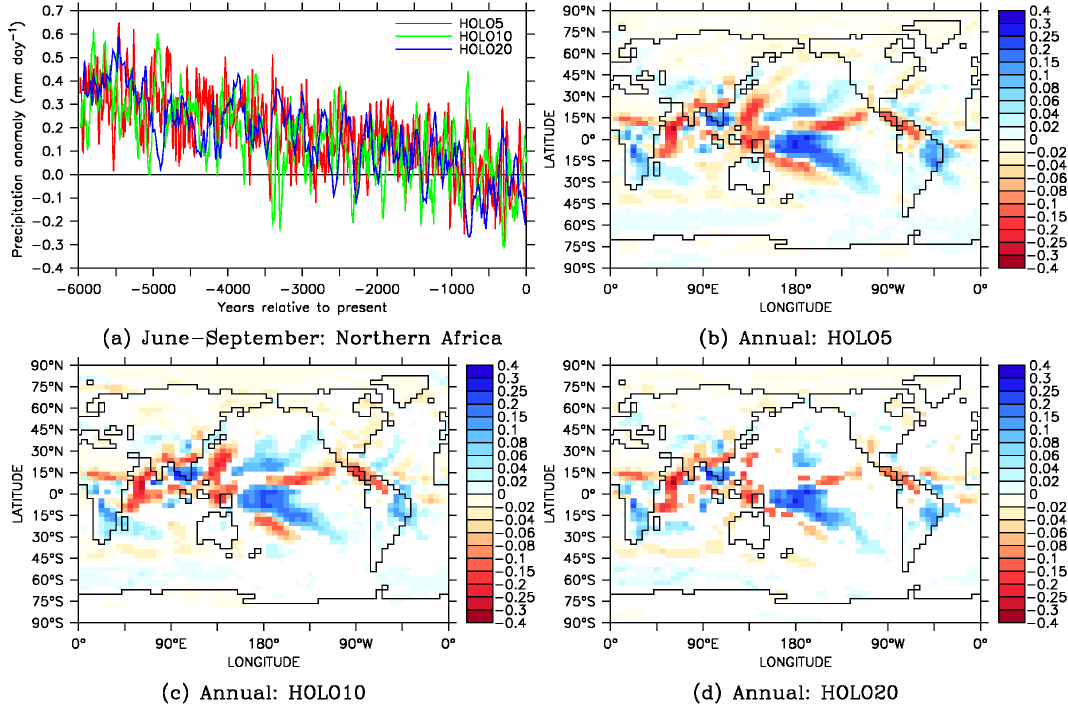
Fig. 10. The evolution of precipitation during the late Holocene: (a) June–September precipitation over Northern Africa (20 ◦ W–30 ◦ E, 10– 25 ◦ N), expressed as an anomaly relative to CONTROL; the values shown are running means across five model years, and (b–d) the linear trend in annual-mean precipitation (mmday − 1 per 1000yr) for experiments HOLO5, HOLO10 and HOLO20, respectively. In (b–d) , only values that are significant at the 95% confidence level are